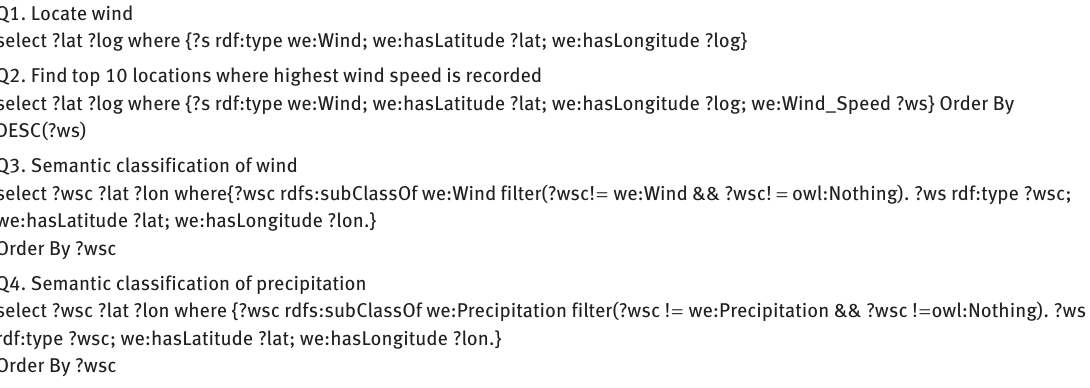
Table 2: Semantic Queries and Their SPARQL Representation. Q1. Locate